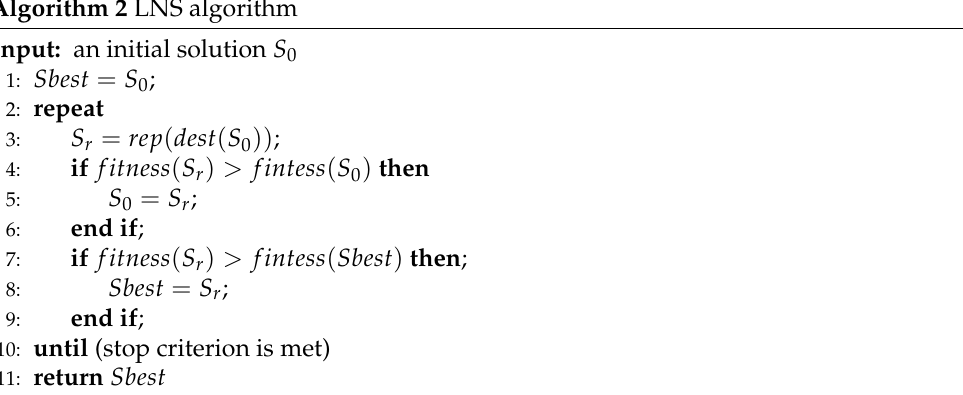
Algorithm 2 LNS